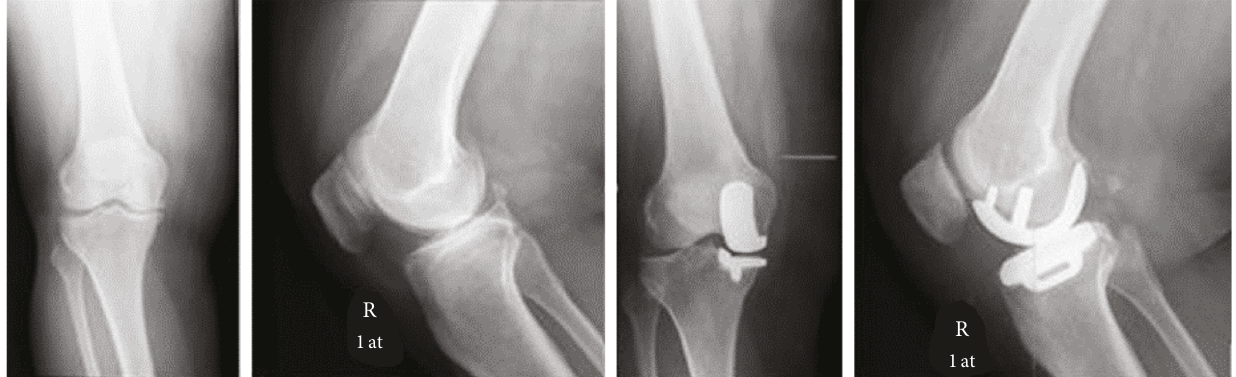
Figure 1: Preoperative and postoperative standing AP and lateral